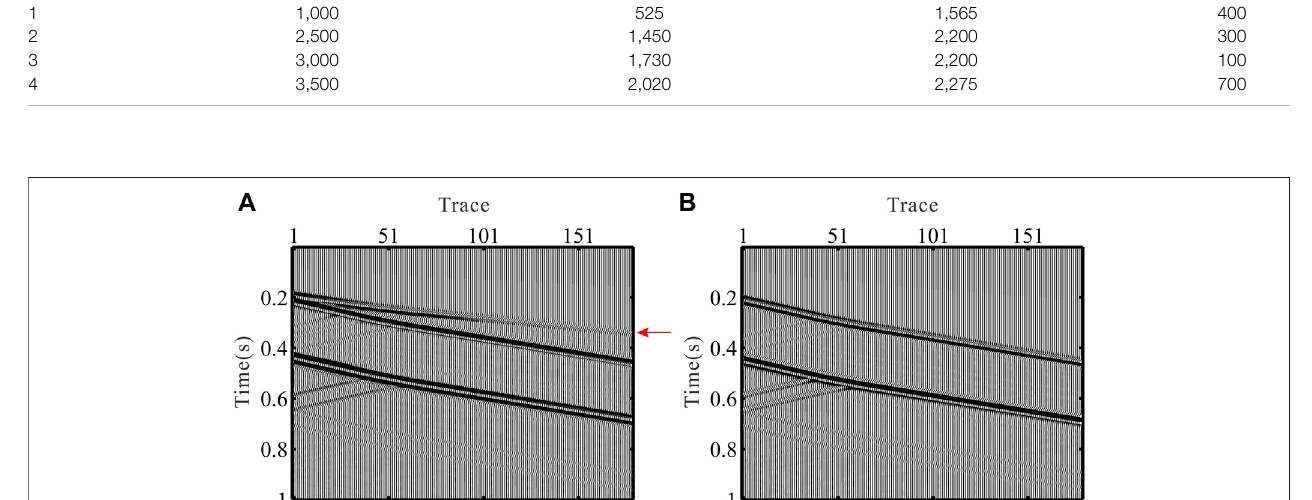
FIGURE 2 | Synthetic VSP data without noises and the geophones are aligned. (A) X-component. (B)